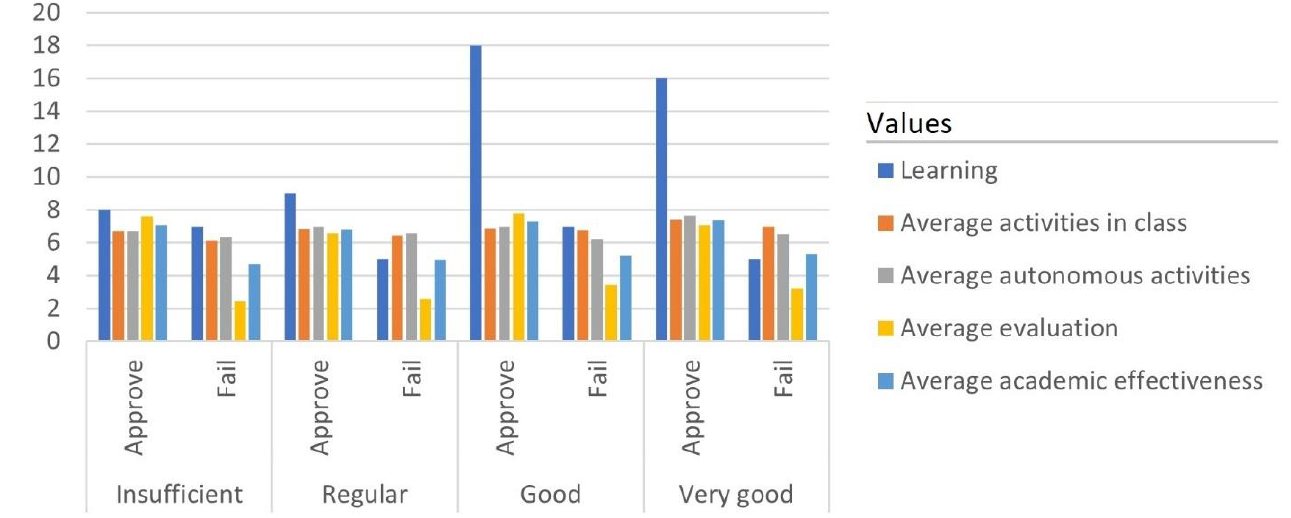
Figure 4. Graph of the trend analysis for the 2021 period.